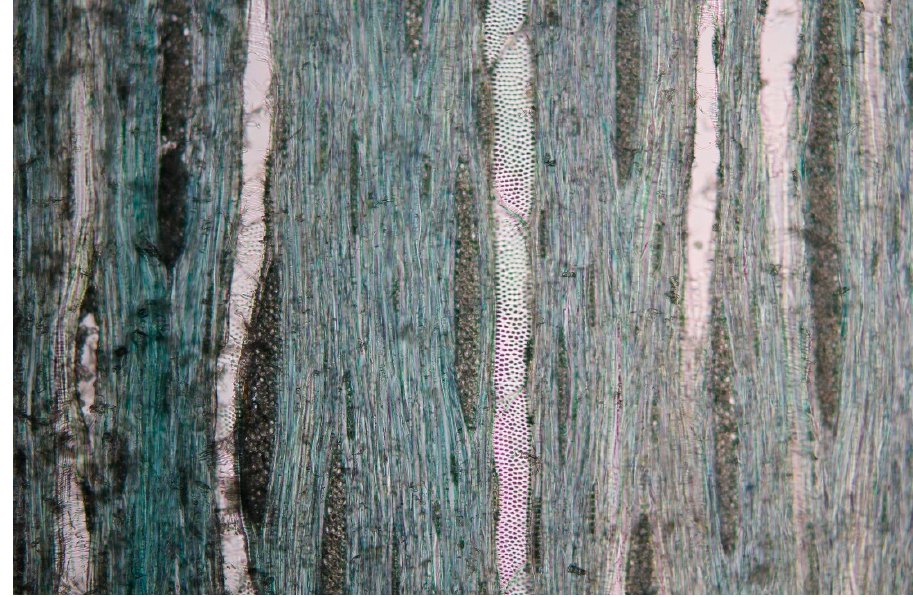
Figure 26. Tangential view of face veneer showing alternate intervessel pitting, spiral thickenings, and cross section of sample perforation plates (100×) that are characteristic of sugar maple (Acer saccharum).